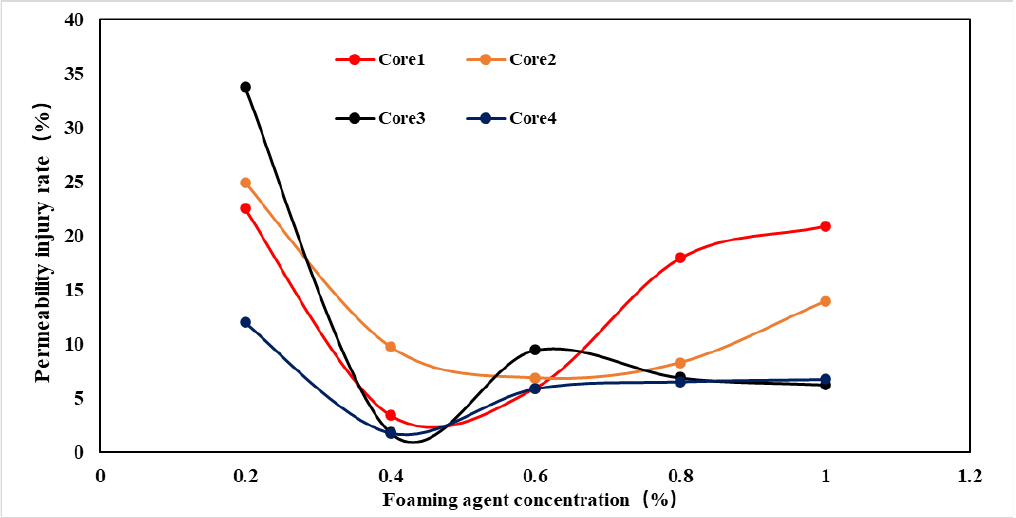
Figure 6. Permeability damage rate changes with the increase of foam concentration. Permeability injury rate is: A − 100% o i a = A o where a is injury rate, %; A 0 is the core permeability before the foaming agent solution damages, A i is the permeability of the core after being damaged by foaming agent solution. From Figure 7, the overall damage rate curves showed a V-shape and differed for different concentrations. The damage rate was minimized at a concentration range of 0.4 – 0.6%. With the increase of concentration, the damage rate tends to increase [38,39].